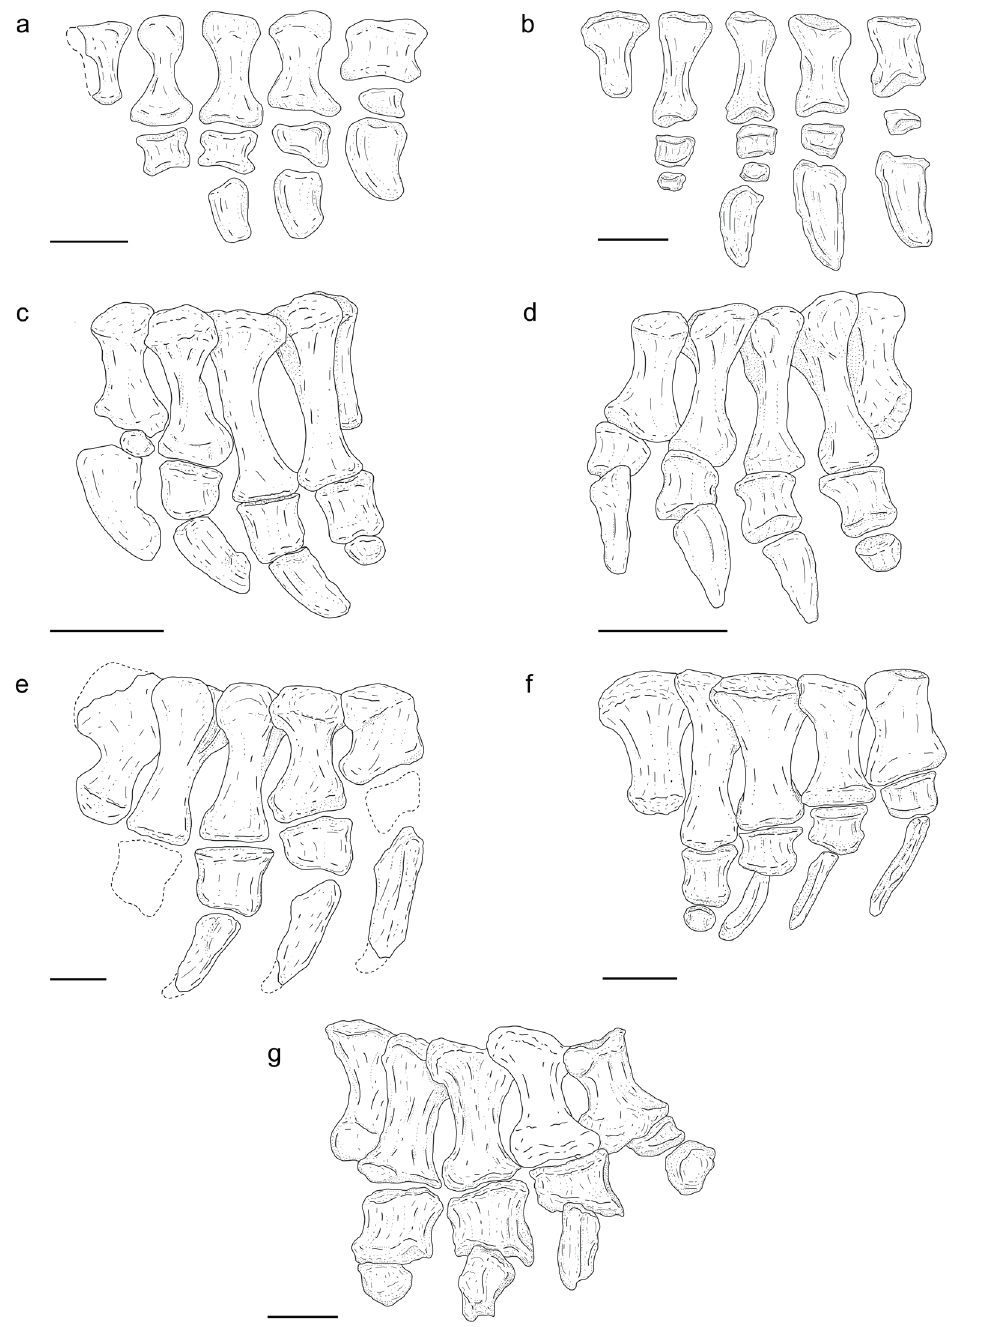
Figure 9 – the best-preserved pedes of titanosaurian sauropods. South American (Argentinean) taxa marked with an asterisk. ( a ) Opisthocoelicaudia skarzynskii, ZPAL MgD-I/48, right pes, redrawn from Borsuk-Bialynicka (1977), ( b ) Epachthosaurus sciuttoi *, UNPSJB-PV 920, right pes, redrawn from Martínez et al. (2004), ( c ) La Invernada taxon*, MUCPv-1533, left pes, redrawn from González riga et al. (2008a), ( d ) Agua del Padrillo taxon*, UNCUYO-LD 313, left pes, redrawn from González riga et al. (2015), ( e ) ? Alamosaurus sanjuanensis , NMMNh P-49967, right pes, redrawn from D’Emic et al. (2011), ( f ) Mendozasaurus neguyelap *, IANIGLA-PV 077/1–10, 078/1–2, 079, right pes, redrawn from González riga et al. (2018), ( G ) Notocolossus gonzalezparejasi *, UNCUYO-LD 302, right pes, redrawn from González riga et al. (2016). Scale bars equal 10